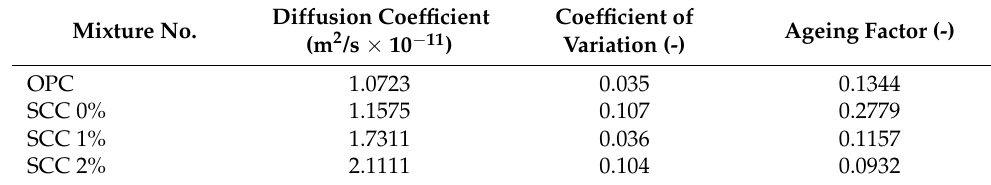
Table 2. Diffusion properties.